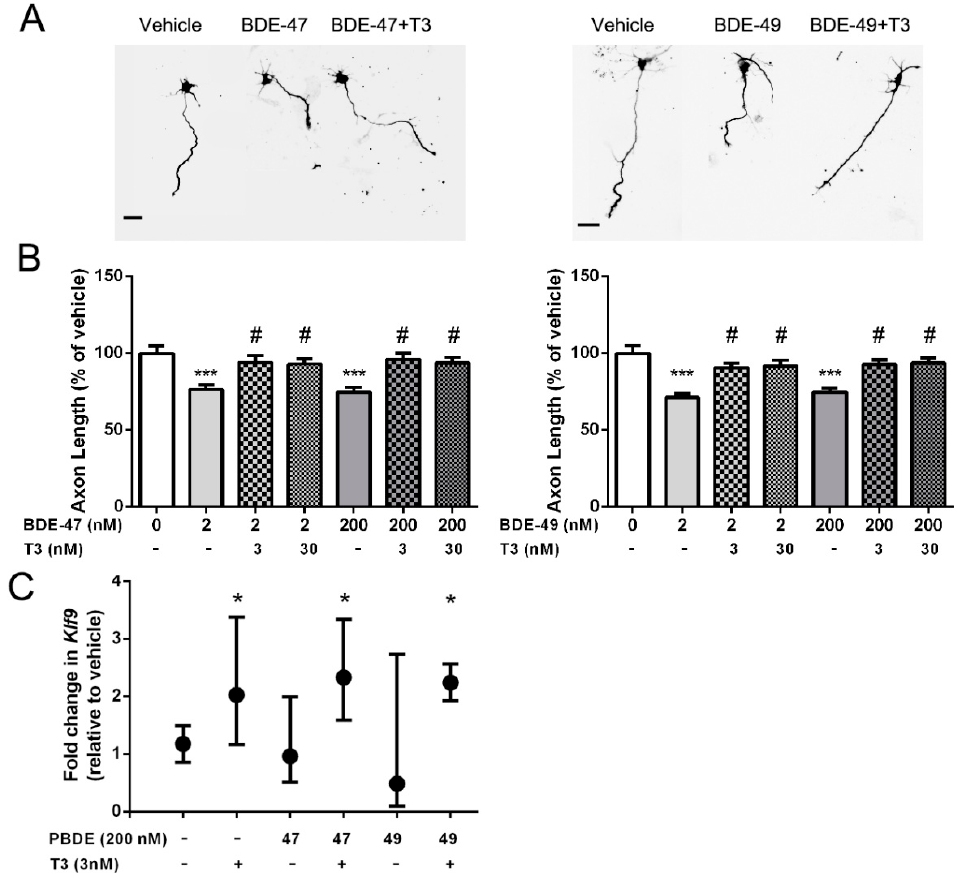
Figure 1. T3 supplementation prevented BDE-47 and BDE-49 inhibition of axonal growth in primary hippocampal neurons. Primary neuron-glia co-cultures dissociated from the hippocampi of P0-1 rats were exposed to vehicle (DMSO diluted 1:1000) or varying concentrations of BDE-47 or BDE-49 in the absence or presence of T3 beginning 3 h after plating. After 48 h exposure, cultures were fixed and immunostained for the axon-selective cytoskeletal protein tau-1. ( A ) Representative